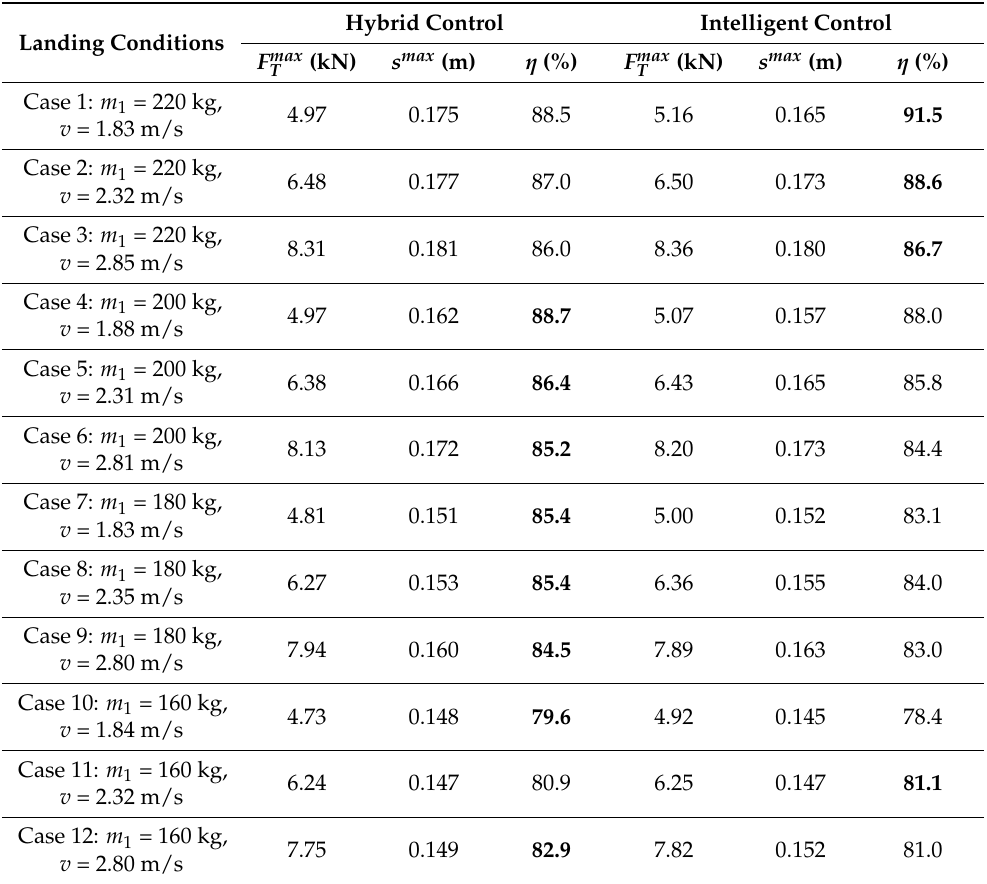
Table 4. Damper performance using the hybrid controller with exact information and intelligent controller in other cases, which are different to training and testing cases. The best efficiency for each case is marked in